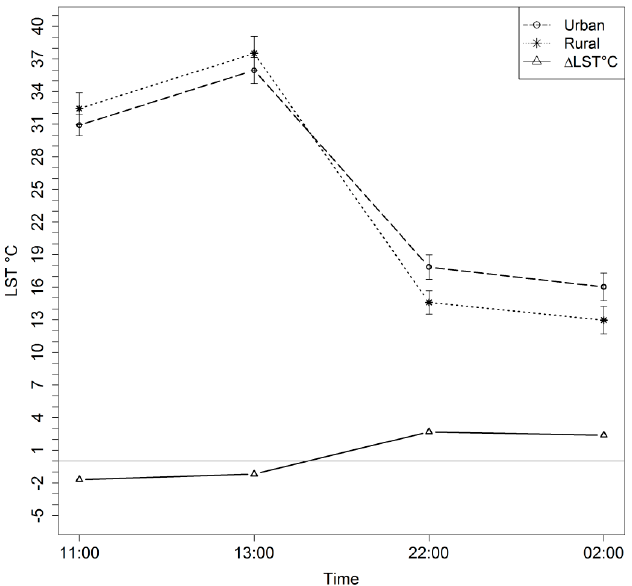
Figure 3. Diurnal variation of average 2014 Land Surface Temperature and Surface Urban Cool Island/Surface Urban Heat Island during the day and night.